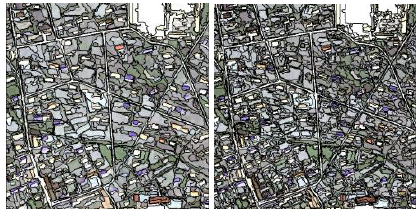
Figure 3. Same scale Multiresoulution segmentation results contrast （ Left with edge information and right without edge information